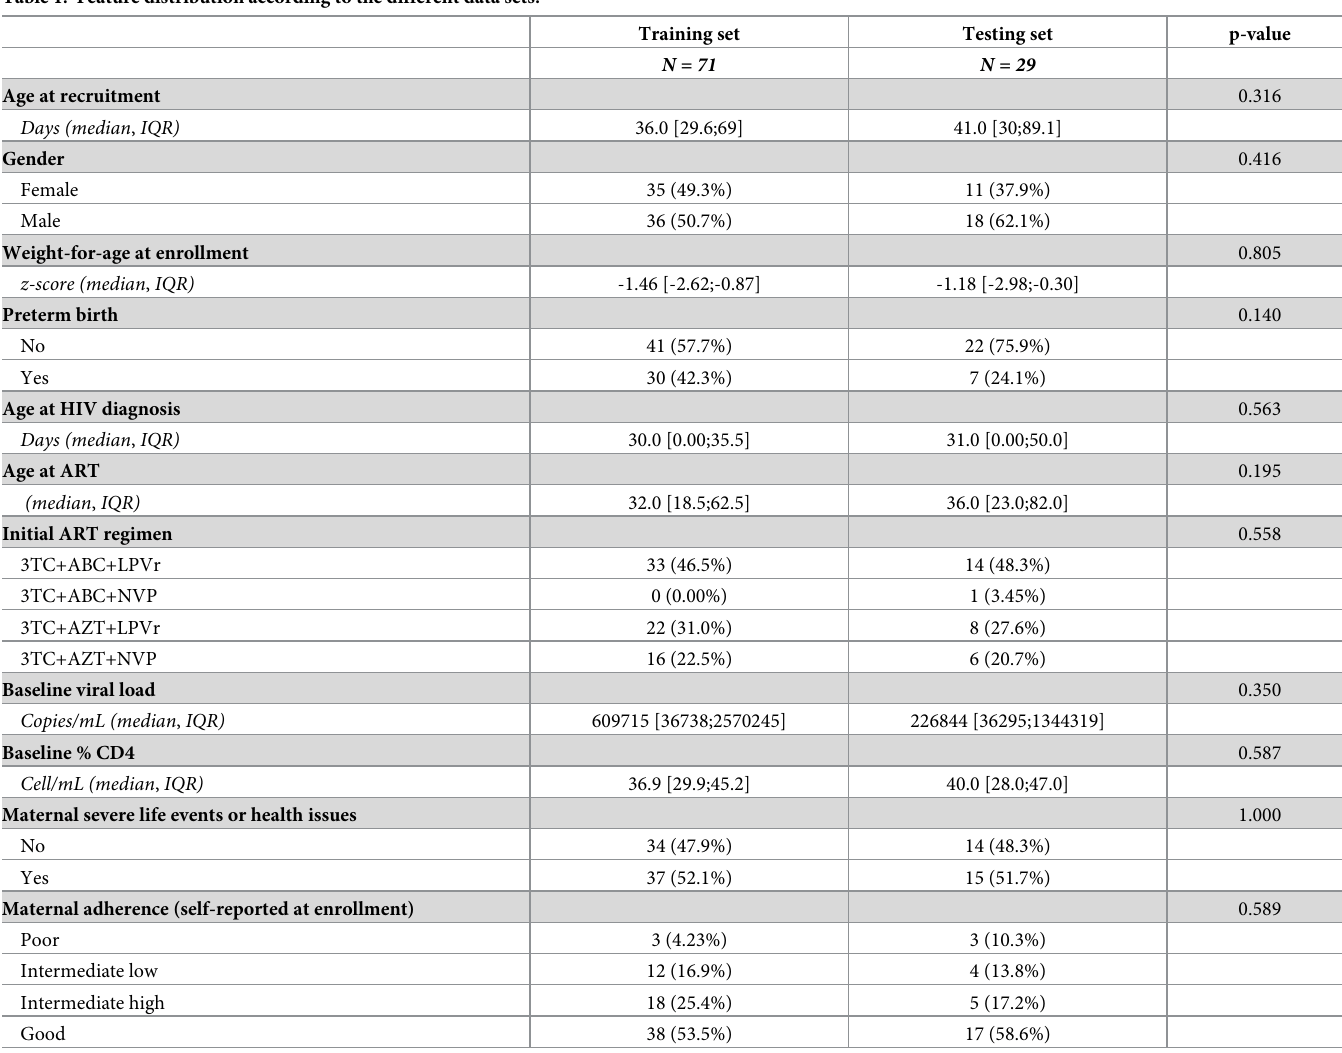
Table 1. Feature distribution according to the different data sets.